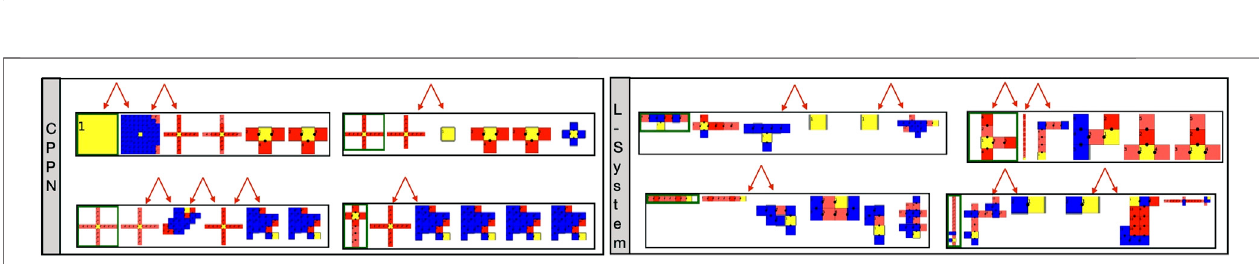
FIGURE11| Examples ofrobotgenealogy.Fromlefttoright,robots gofromyoungertoolder. Theyoungestrobotswererandomlysampledfromgeneration59of a random run. The red arrows point out non-smooth morphological transitions from parent to child.